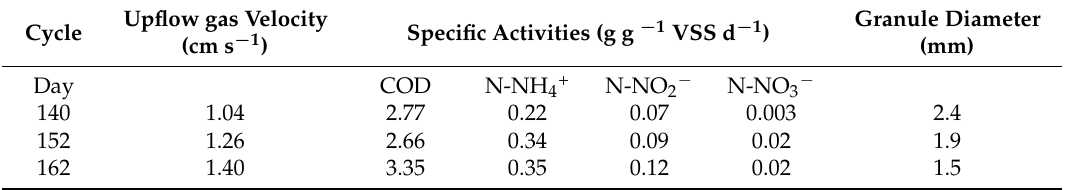
Table 2. Specific activity rates in SBR III operated with three different upflow gas velocities. Upflow gas Cycle